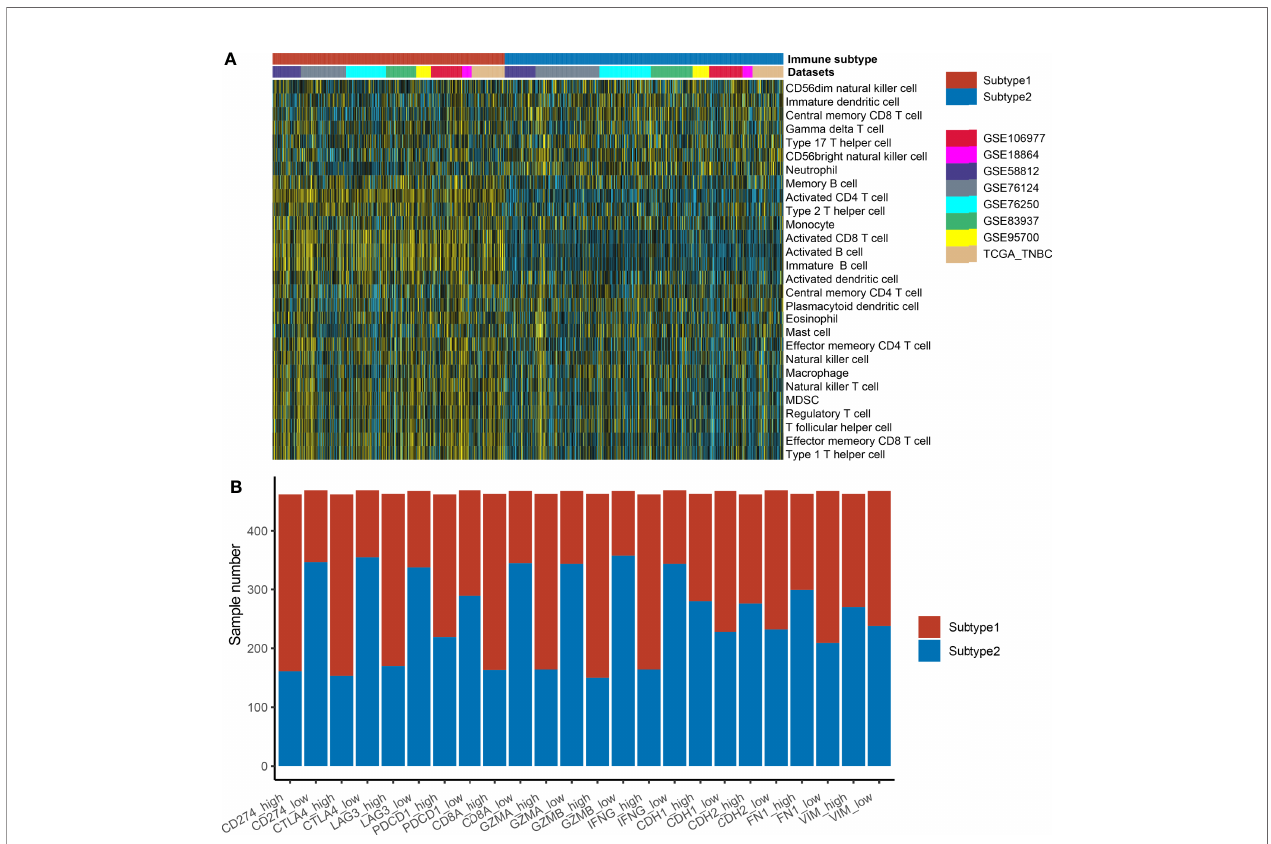
FIGURE 3 | The distribution of immune cell enrichment scores and immune-related markers in two different immune subtypes. (A) The immune cell enrichment scores in two subtypes are displayed by heatmap. (B) The immune-related markers in two different immune subtypes are displayed by the boxplot. The expression values of these markers in each dataset were transformed into “ high ” or “ low ” by the median value of the marker. Then, the correlation of immune subtypes (subtype 1 or subtype 2 groups) and expression groups (high or low groups) was tested by the Fisher ’ s